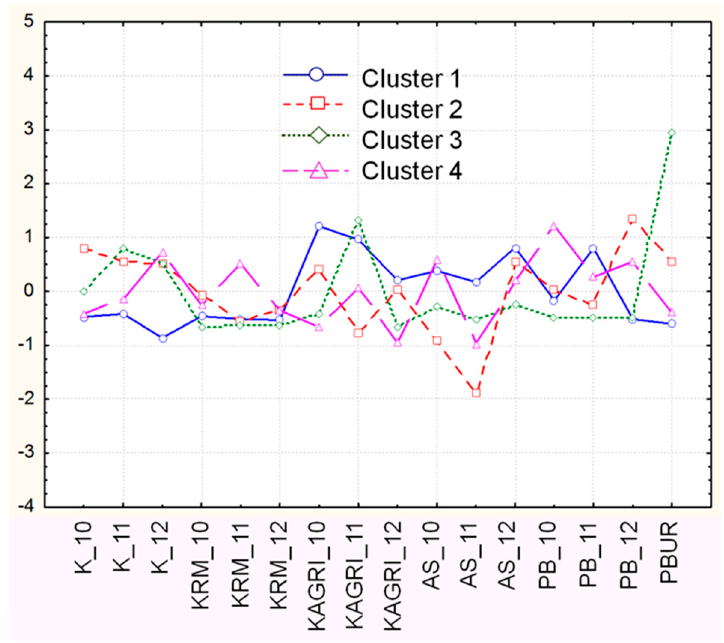
Figure 3. Averages (normalized) of each cluster of variables for each sampling location.